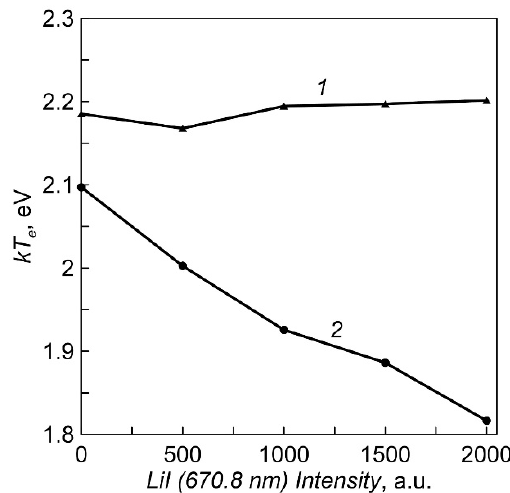
Figure 6. The dependencies of the plasma electron temperature on intensity of LiI line (Li vapor density). 1 —equipotential crucible, 2 —crucible with an insulated multi-aperture lid.